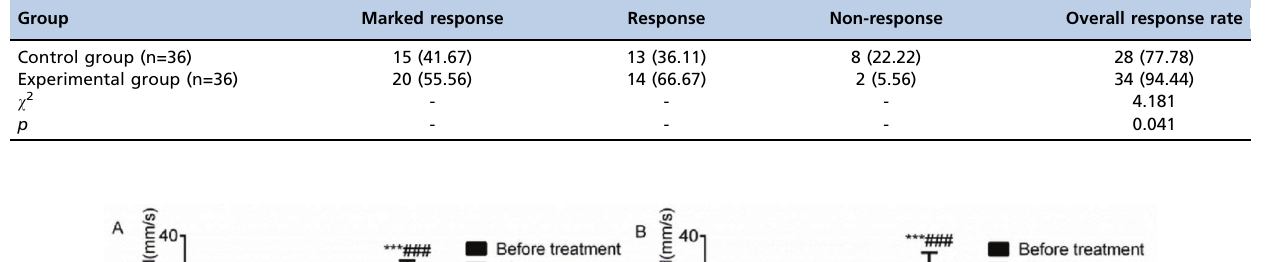
Table 2 - Comparison of clinical efficacy between the two groups [n (%)].